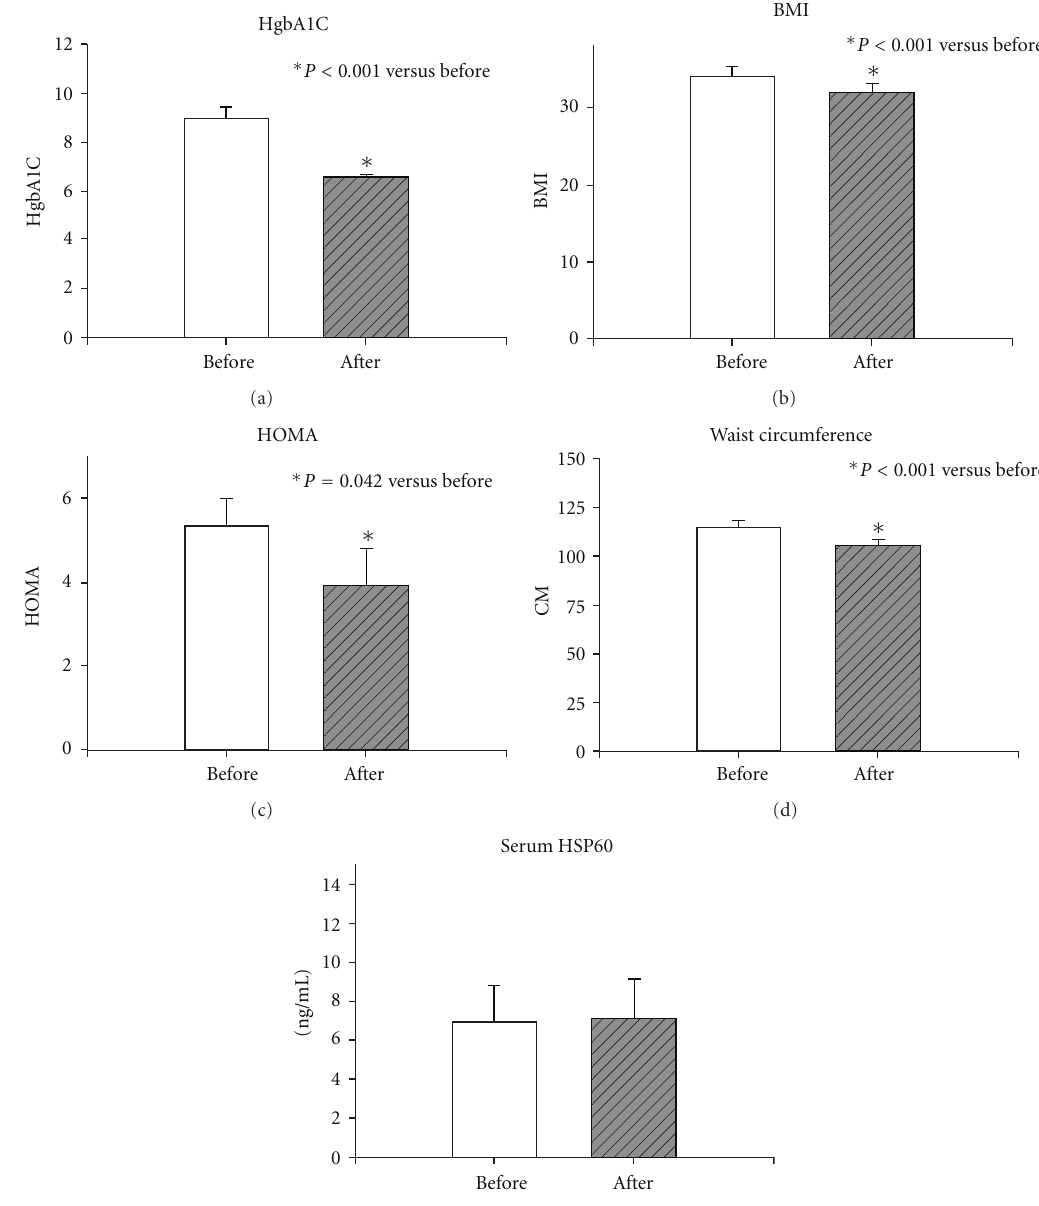
Figure 1: (a) HgbA1C before and after intensive treatment. (b) BMI before and after intensive treatment. (c) HOMA before and after intensive treatment. (d) Waist circumference before and after intensive treatment. (e) Serum HSP60 levels by ELISA before and after intensive treatment. ∗ P < 0 . 001 except c, where P < 0 .